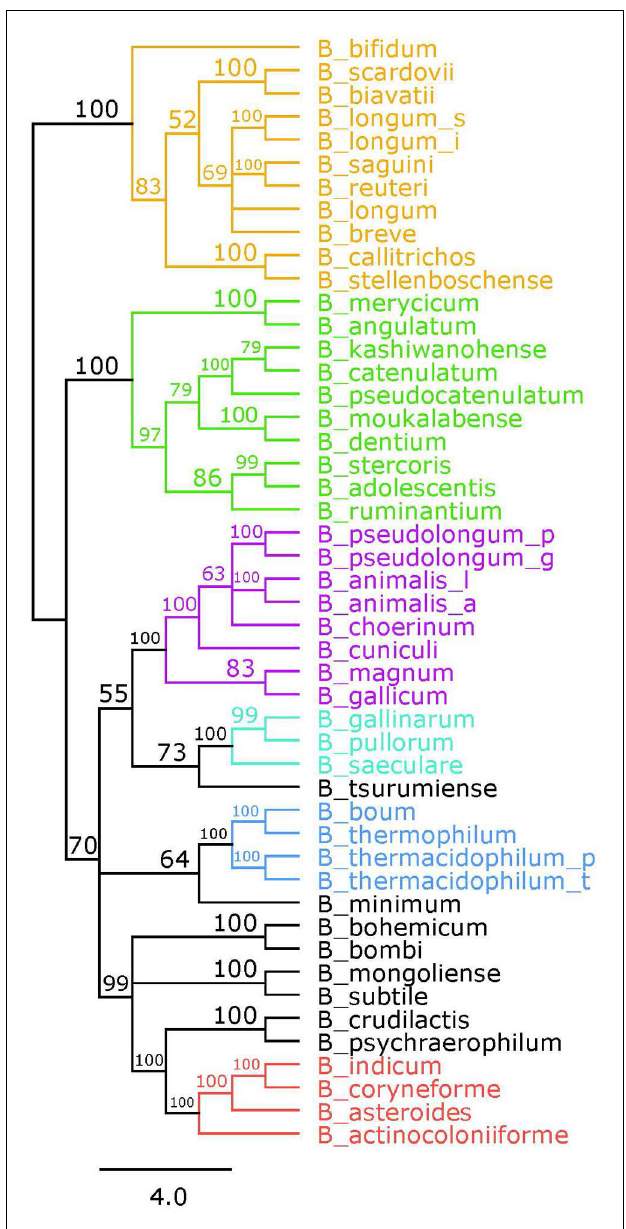
FIGURE 2 | Glycolytic proteins concatenated tree. Consensus tree based on alignment of the concatenated amino acid sequences of the glycolysis pathway found in Bifidobacterium . Trees were made using RaxML. Bootstrap values are found on each node. Phylogenetic groups are colored as follows: Bifidobacterium longum is orange, Bifidobacterium adolescentis is green, Bifidobacterium psdeudolongum is purple, Bifidobacterium pollorum is blue-green, Bifidobacterium boum is blue, and Bifidobacterium asteroides is red. Species names follow the naming convention from Table 1 .